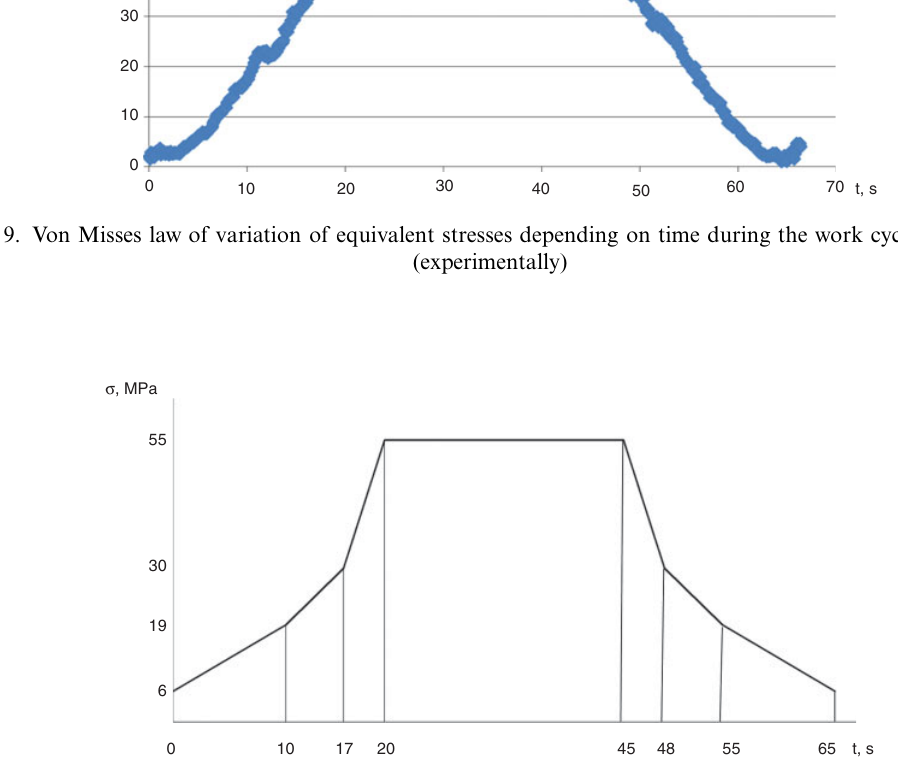
Fig. 10. Von Misses law of variation of equivalent stresses depending on time during the work cycle of a crane (calculation)